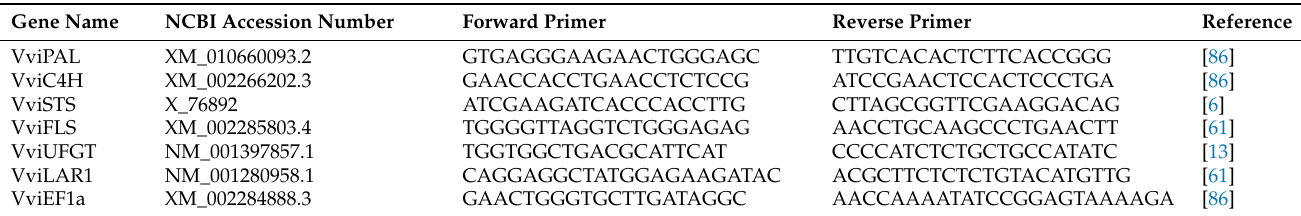
Table 3. List of primers used in RT-qPCR